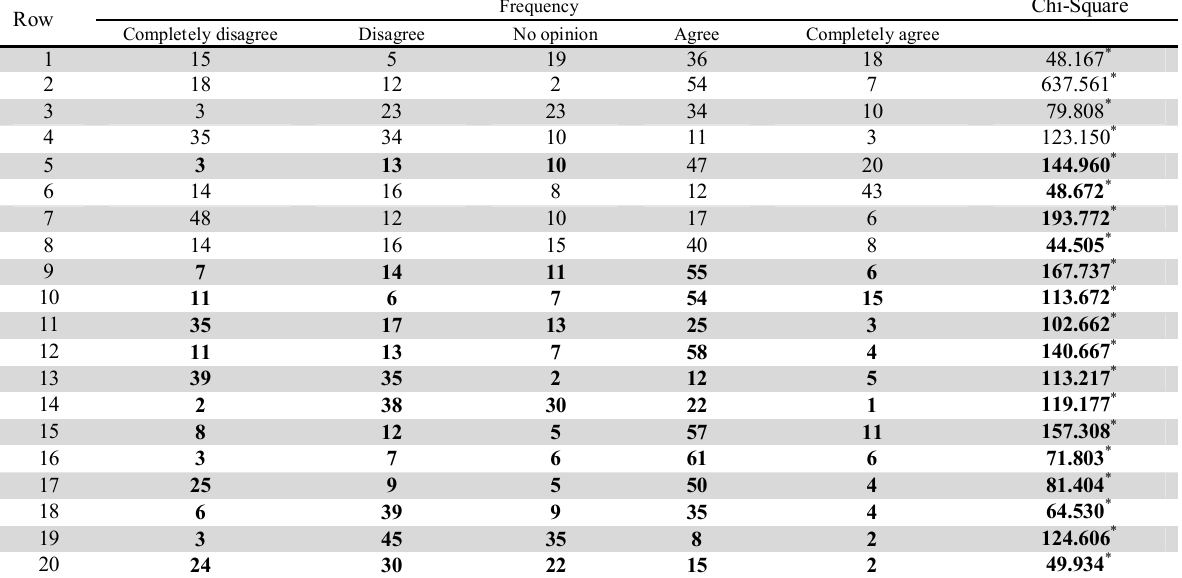
The summary of Chi-Square test on various